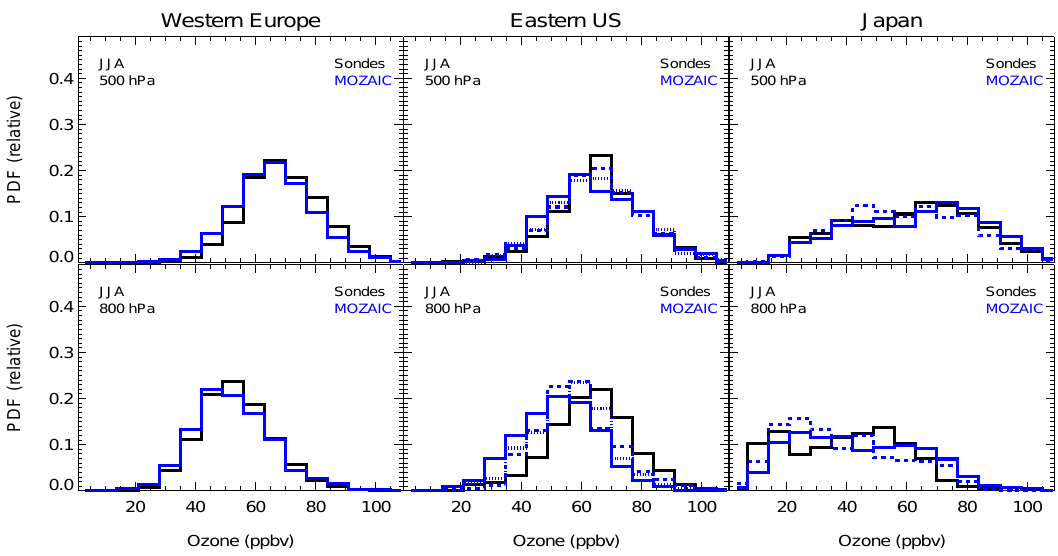
Fig. 9. Probability distribution functions (PDFs) of ozone profiles at 450–550hPa from MOZAIC aircraft that are located at airports within the selected region (blue lines) for Western Europe (left) and Eastern US (right), and for DJF (top) and JJA (bottom). For Eastern US, profiles were taken over Boston (solid), NY (dashed), and Washington (dotted), for Western Europe, profiles were taken over Frankfurt, and for Japan, MOZAIC aircraft data from Tsukuba and Osaka were used. PDFs of regionally aggregated ozonesonde observations for the same altitude intervals are shown as thick black